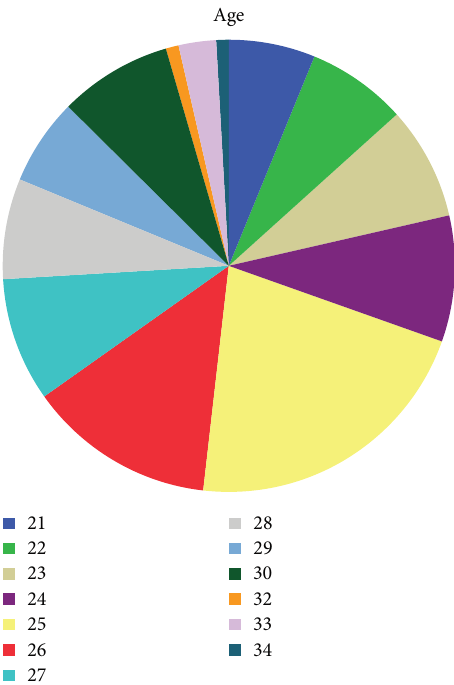
F IGURE 2: The proportion of different ages in the sample.